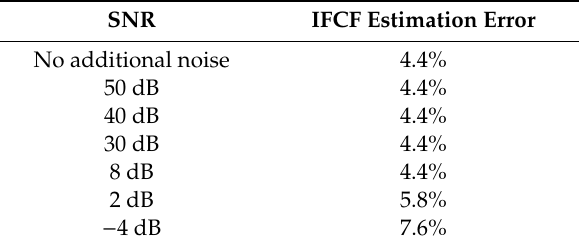
Table 2. IFCF estimation errors for di ff erent noise